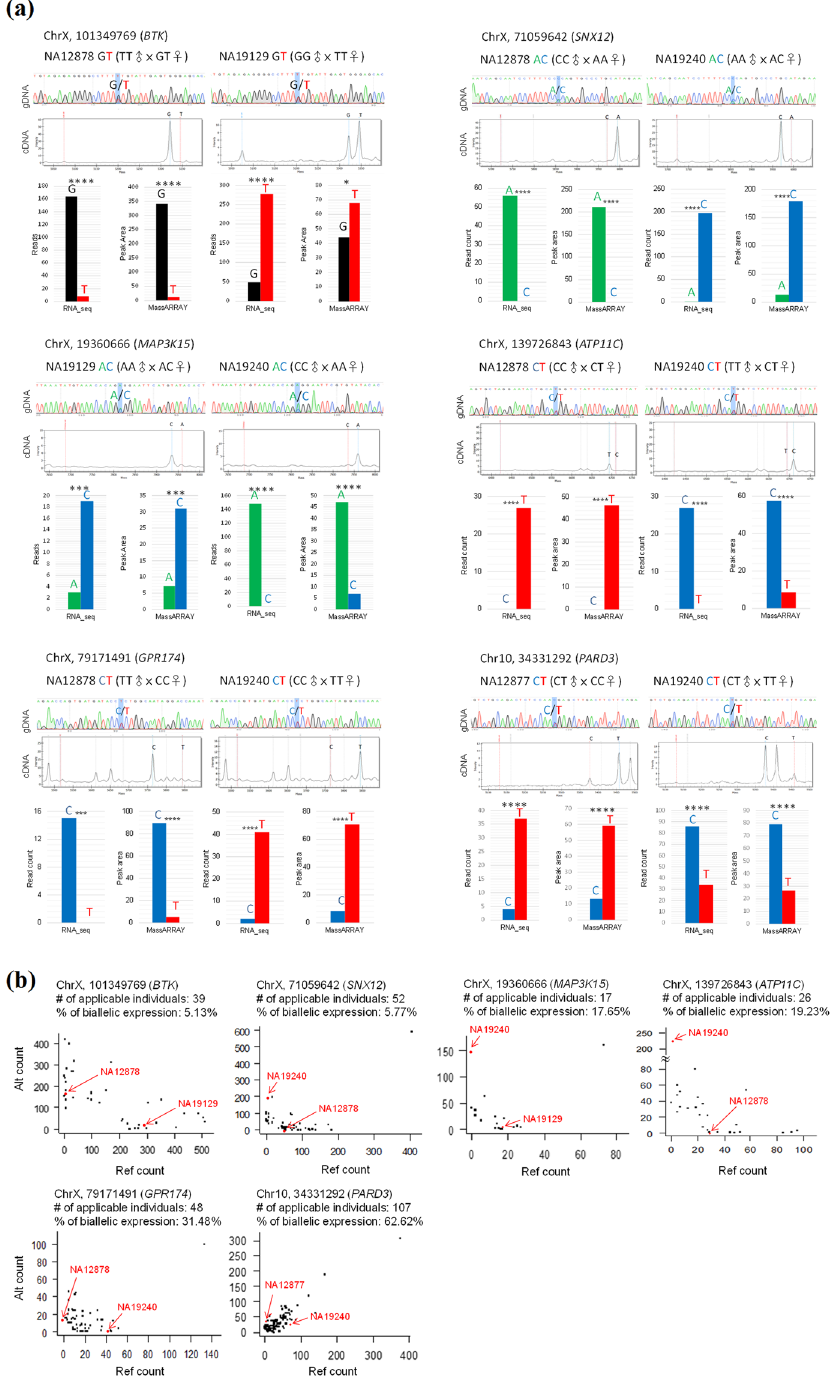
Figure 5. Validation of the Category 1-1 ASE sites failing to the r = a test. ( a ) Experimental validation of the existence of heterozygosity and the status of allelic expression for each site in the corresponding LCL cell lines using Sanger sequencing and MassARRAY platform. Bases were colored as: A, green; C, blue; G, black; T, red. Significant differences between the paternally expressed read count and the maternally expressed read count (from the RNA-seq data) and between the Peak areas (from the volume of peak in the MassARRAY data; see Dataset 3) were evaluated using the Chi -square test. *** P < 0.001, **** P < 0.0001. ( b ) Population-scale allelic expression patterns for the failing-test sites. “% of biallelic expression” represents the percentage of the Geuvadis individuals with biallelic expression at the failing-test sites. The red dots represent the allelic expression patterns of the failing-test sites between the corresponding heterozygous individuals listed in Fig. 1b (i.e., NA12877, NA12878, NA19129, or